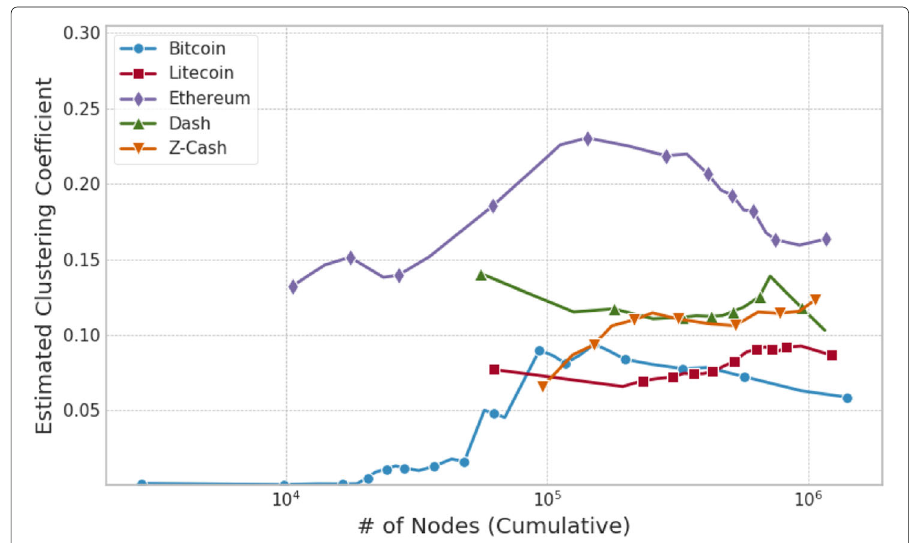
Fig. 8 Clustering coefficient of CMTG vs. the number of its nodes